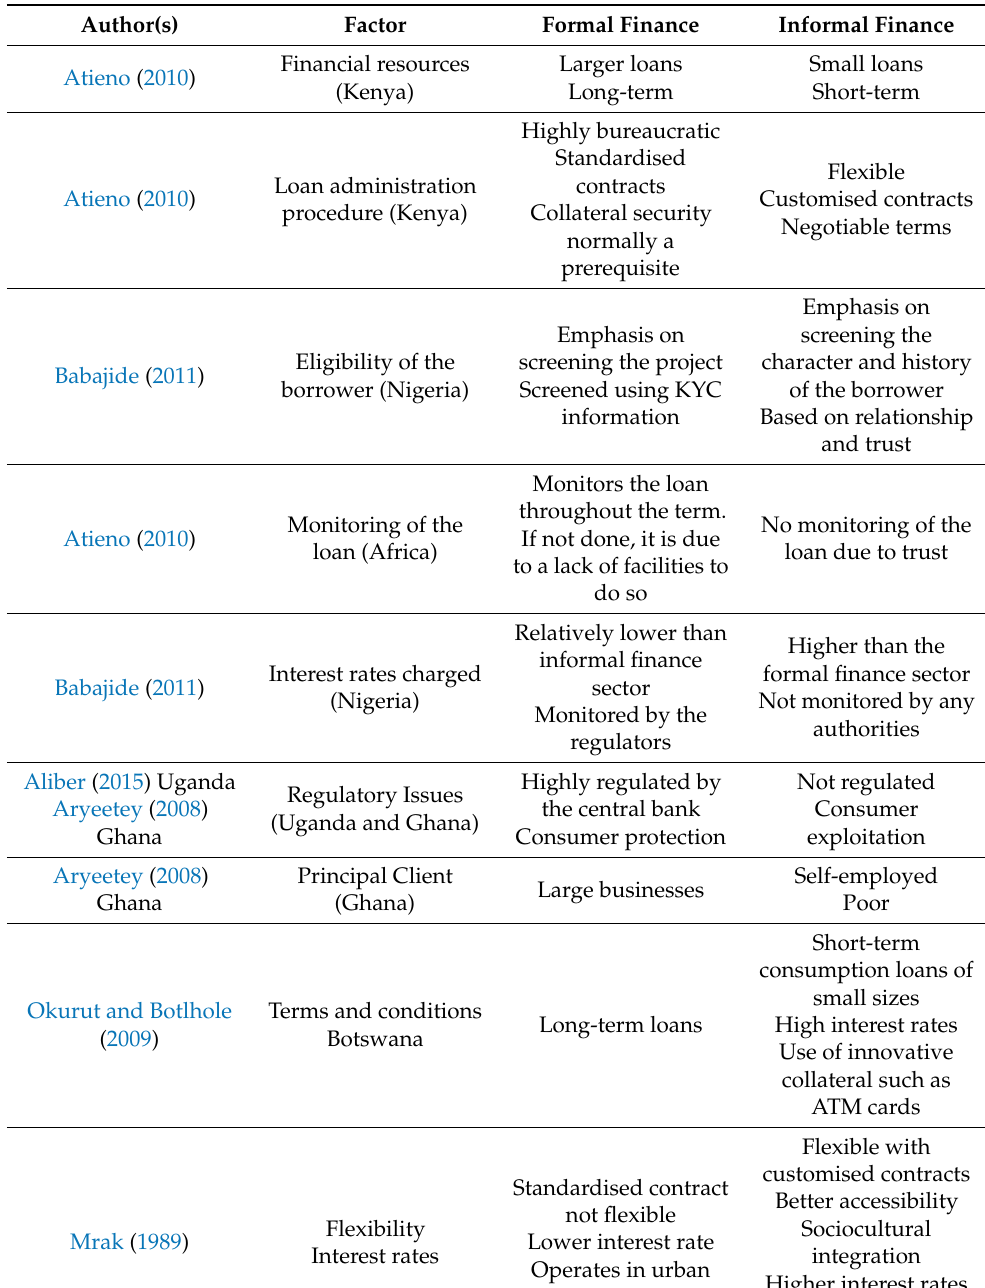
Table 1. Comparison of formal and informal finance in African